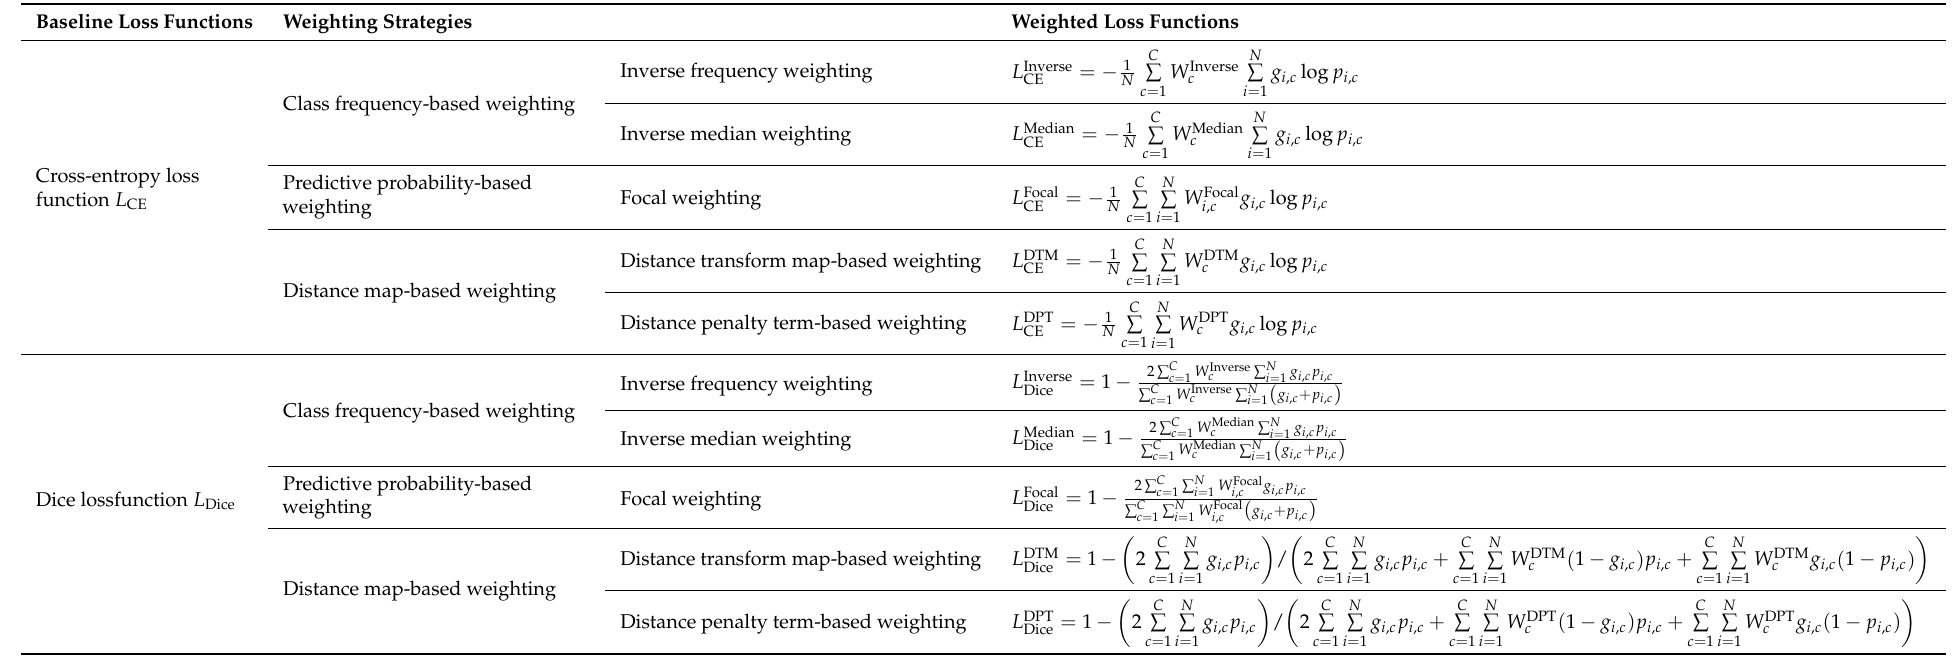
Table 1. Overview of the weighted loss